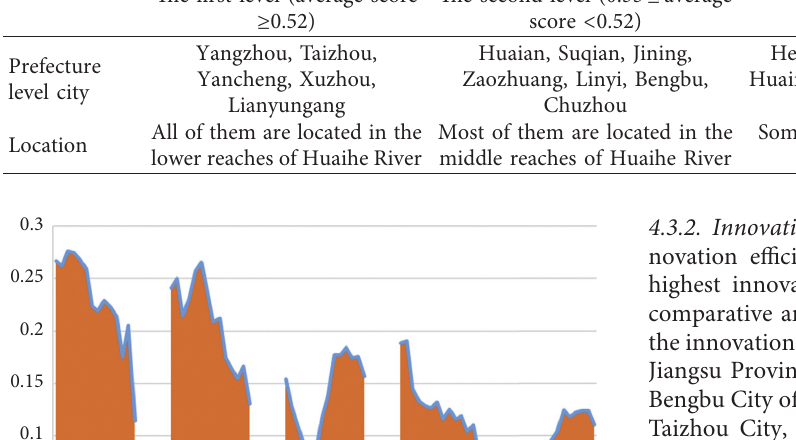
Table 3: Clustering of average score level based on comprehensive evaluation. The first level (average score